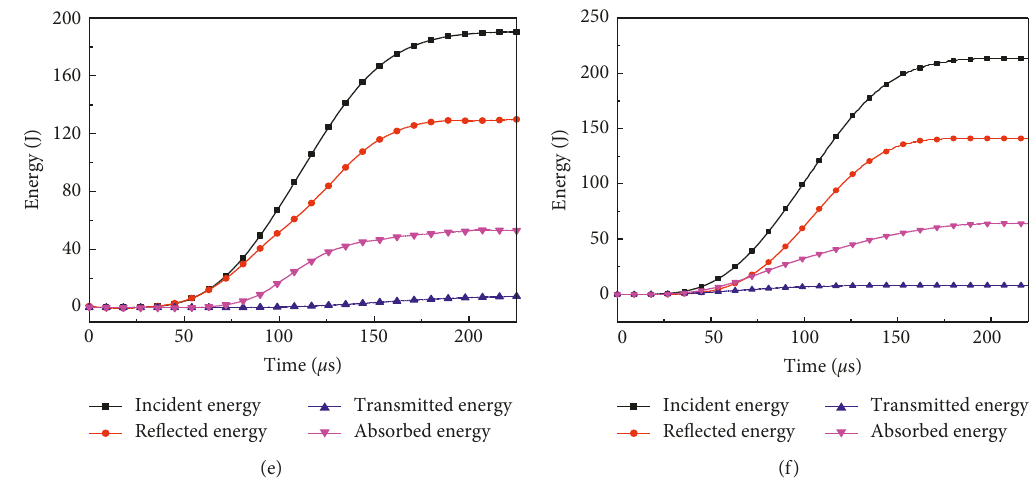
Figure 9: Energy-time curves of samples under impact loading. (a) RS-1. (b) RS-2. (c) RS-3. (d) RS-4. (e) RS-5. (f) RS-6. Table 2: Test results of the energy distribution of samples.